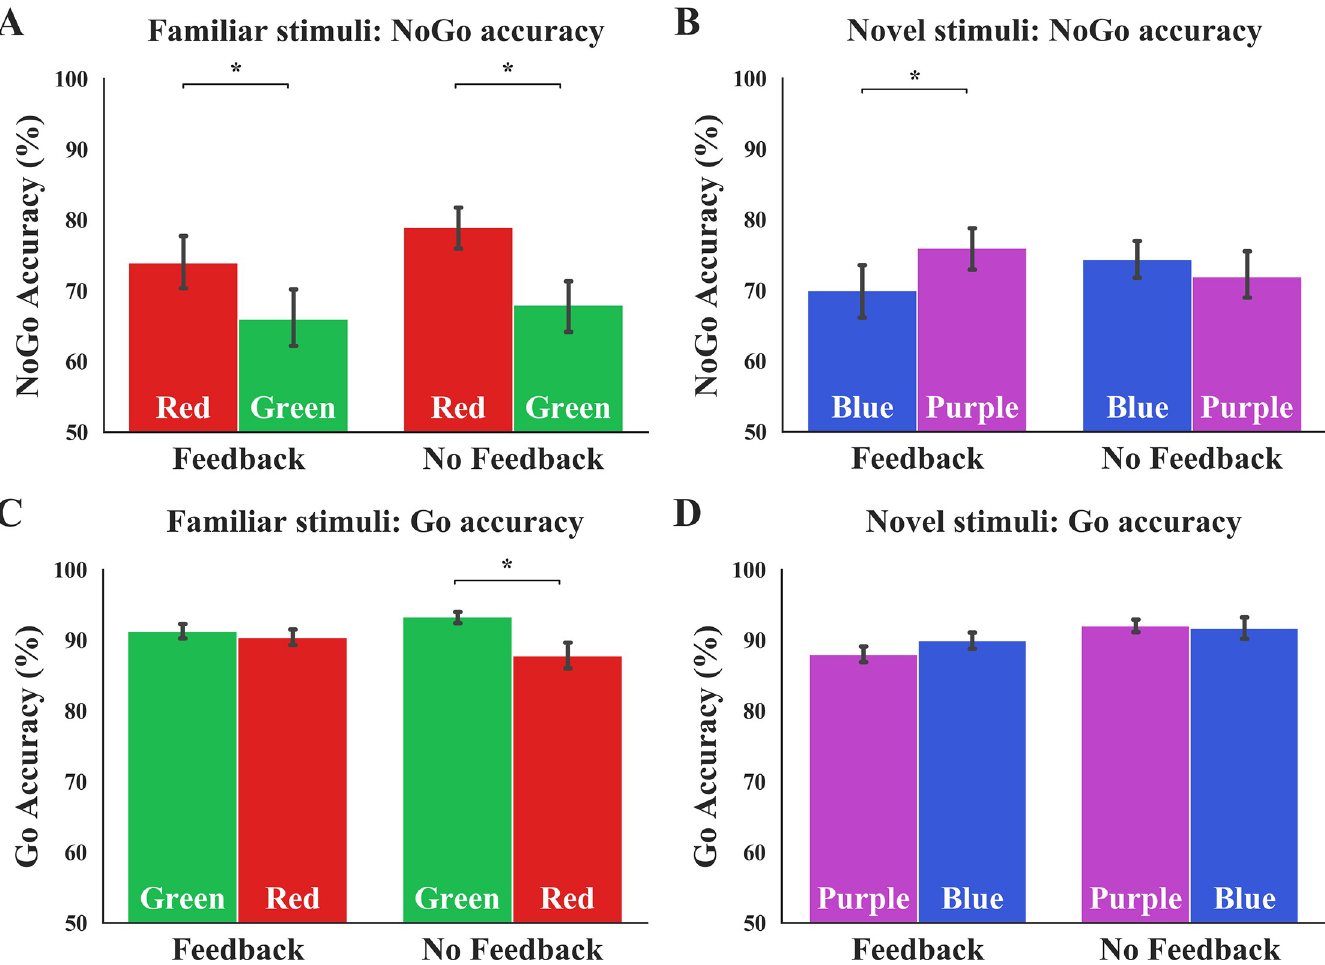
Fig 3. The effects of performance feedback on NoGo and Go accuracy. (A) Performance feedback does not significantly disrupt well-established habits. In the Familiar condition, both Feedback and No-Feedback groups display a similar mapping-related change (interaction p = .513) in NoGo accuracy. Note that the non- significant interaction indicates the comparable mapping-related accuracy change across feedback groups. (B) NoGo accuracy in the Novel condition is significantly improved by performance feedback (sig. interaction of p = .028) when controlling for Age (which was significantly different across the Feedback groups). (C) Performance feedback protects against habitual Go actions. Providing cumulative performance feedback prevented the mapping-related Go accuracy change when managing Familiar stimuli (Feedback x Color–Response_Mapping interaction p = .019). (D) Performance feedback did not significantly improve Go accuracy in the Novel condition (Feedback x Color–Response_Mapping interaction p = .05). Error bars denote SEM. Color of bars reflects NoGo and Go stimulus